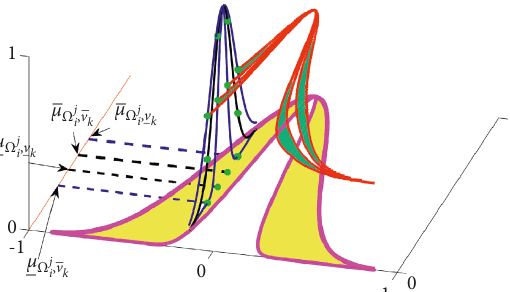
Figure 4: A schematic view of the